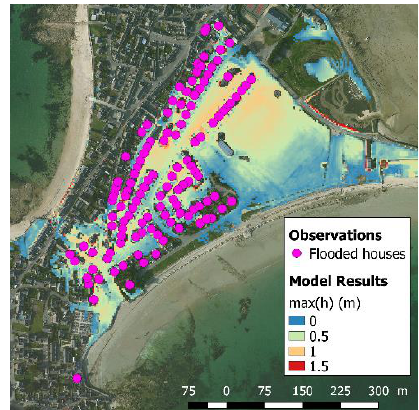
Figure 1. Location and topo-bathymetry of the study site ( a , b ) and computational domains of the models (WW3 and SWASH) of the modeling chain ( a ). The green star indicates the location of the offshore wave forcing. The topo-bathymetry is shown in terms of elevation with respect to the national vertical reference datum (IGN69). Adapted from (Idier et al., 2020).